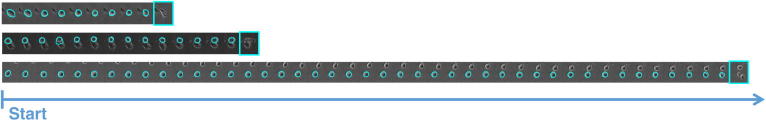
Three examples of mitotic events detected for FUCCI MIA PaCa-2 “DMSO control”, “treatment with 3 nM paclitaxel” and “treatment with 30 nM paclitaxel” data (from top to bottom).